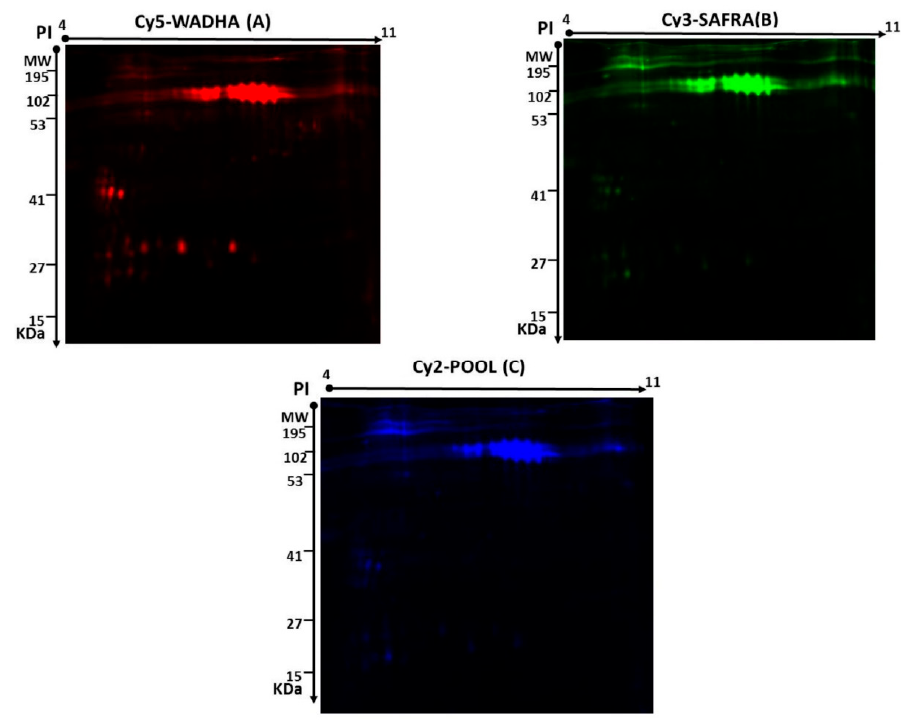
Figure 1. Representative fluorescent protein profiles of a two-dimensional difference in gel electrophoresis (2D-DIGE) containing: milk fat globule membrane (MFGM)-Safra milk samples labeled with Cy3 ( A ), MFGM-Wadha milk samples labeled with Cy5 ( B ), and pooled internal control labeled with Cy2 ( C ).